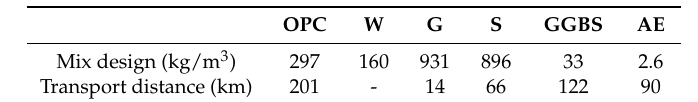
Table 5. Concrete mix design and transportation